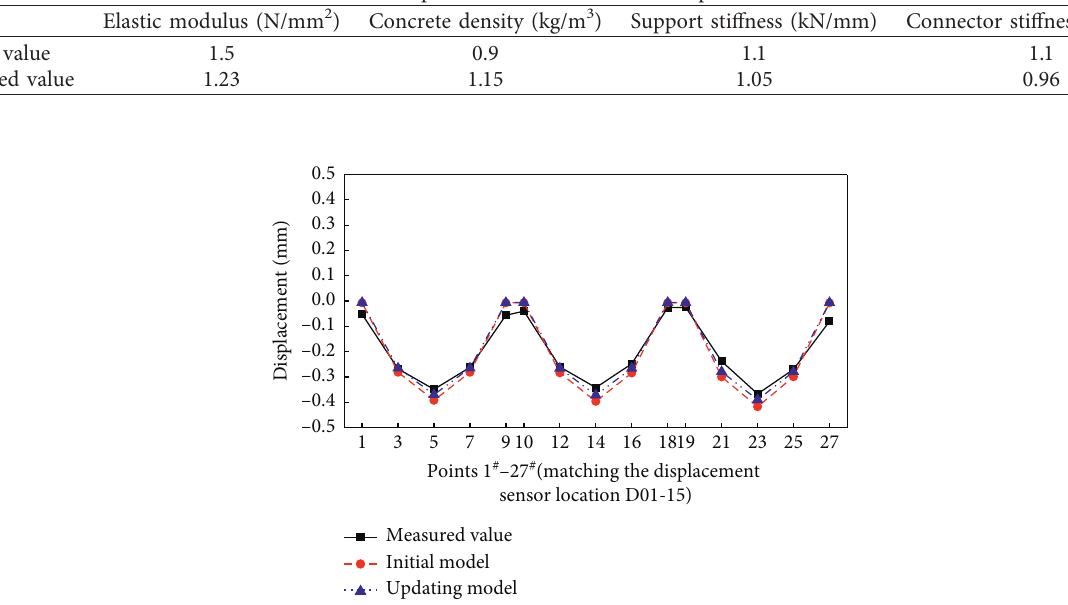
Figure 20: Displacement under a uniformly distributed load before and after model